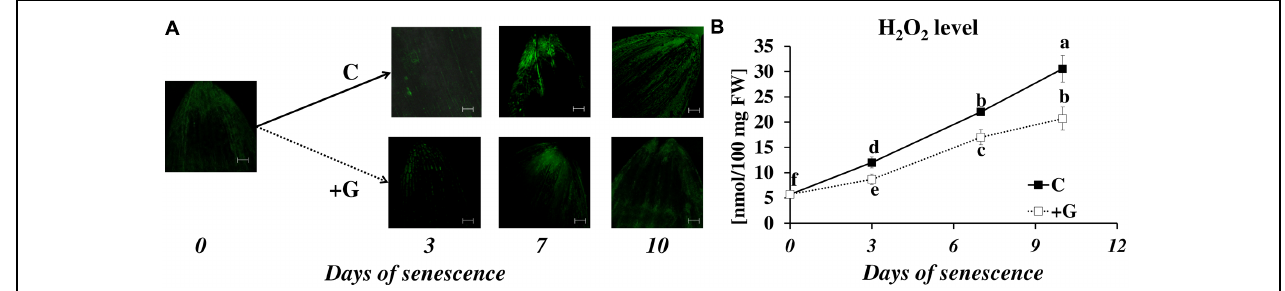
FIGURE 7 | Senescence-related hydrogen peroxide production in dark-incubation in the presence of PAO activity inhibitor in barley leaves. (A) In situ detection of hydrogen peroxide with confocal microscopy and the fluorescent probe 2 (cid:4) ,7 (cid:4) − dichlorofluorescein. The bar indicates 200 μ m. (B) H 2 O 2 level determined with a spectrophotometric method based on titanium (Ti 4 + ) estimated throughout senescence in C (solid line)- control leaves and after application of polyamine oxidase (PAO) activity inhibitor, + G (dotted line) leaves treated with 50 μ M guazatine (G) – PAO activity inhibitor. The differences in the parameters were analyzed for statistical significance using one-way ANOVA and the Tukey–Kramer Multiple Comparison Test ( n = 9, p < 0.01). The same letters on bars describe non-significant differences between